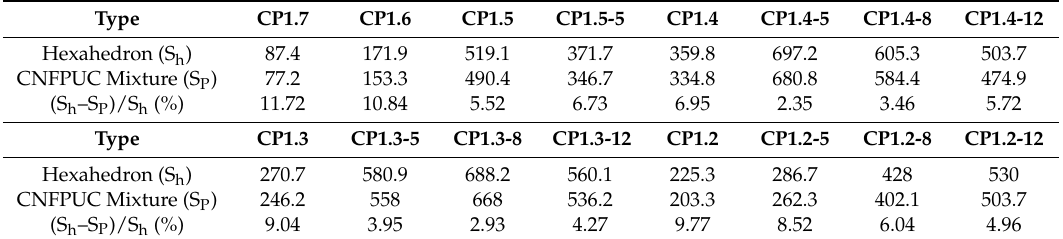
Table 7. Sensitivity error between sampling hexahedron and corresponding mixture.